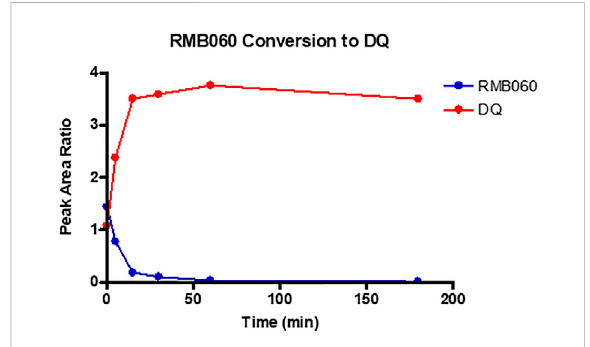
FIGURE 3 Conversion of RMB060 into DQ during 3-hour incubation in human plasma.